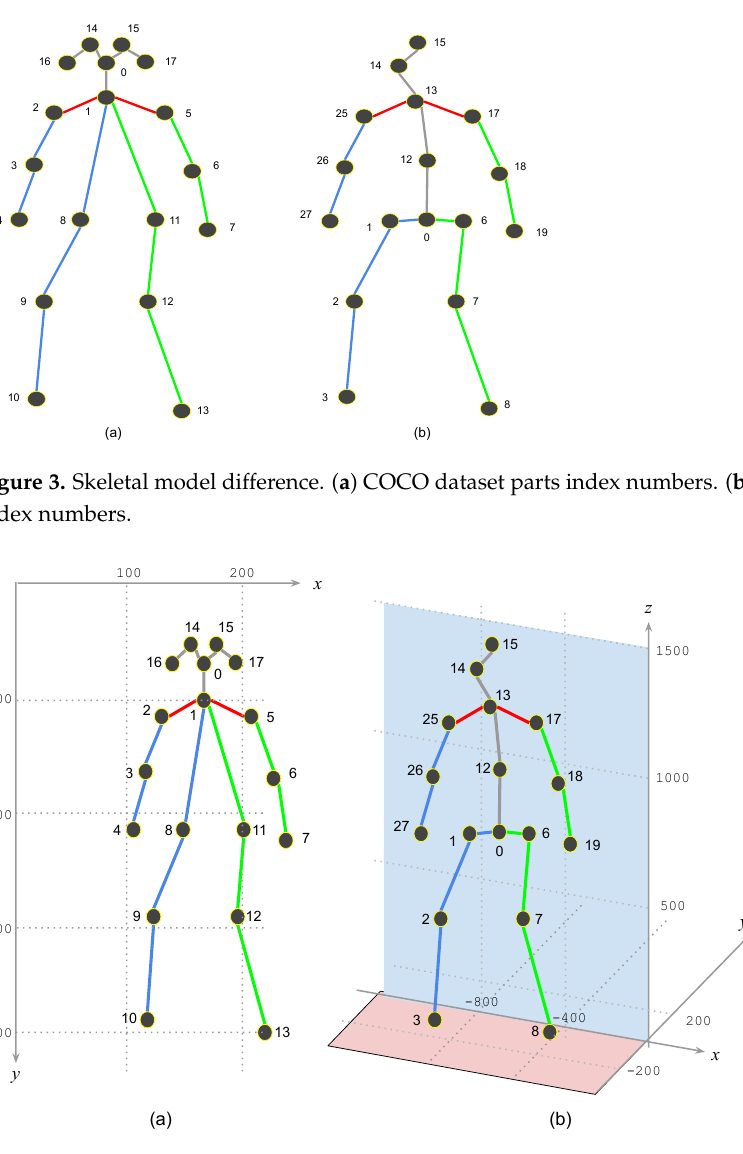
Figure 4. The coordinate system difference between ( a ) OpenPose. The joint positions are labeled in 2D locations. ( b ) SYEB. The joint positions are in 3D. The depth information is inferred by the embedded 3D joint position